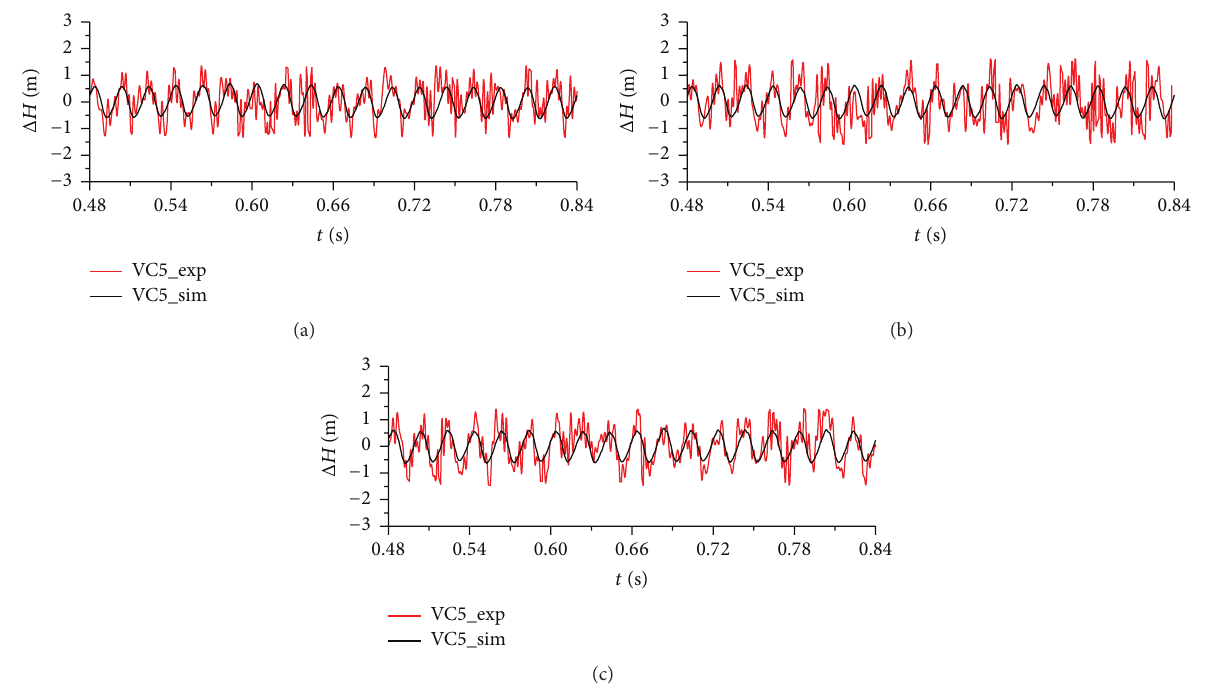
Figure 4: Comparison of the experimental and numerical pressure variations in three models: (a) M1, (b) M2, and (c) M3.